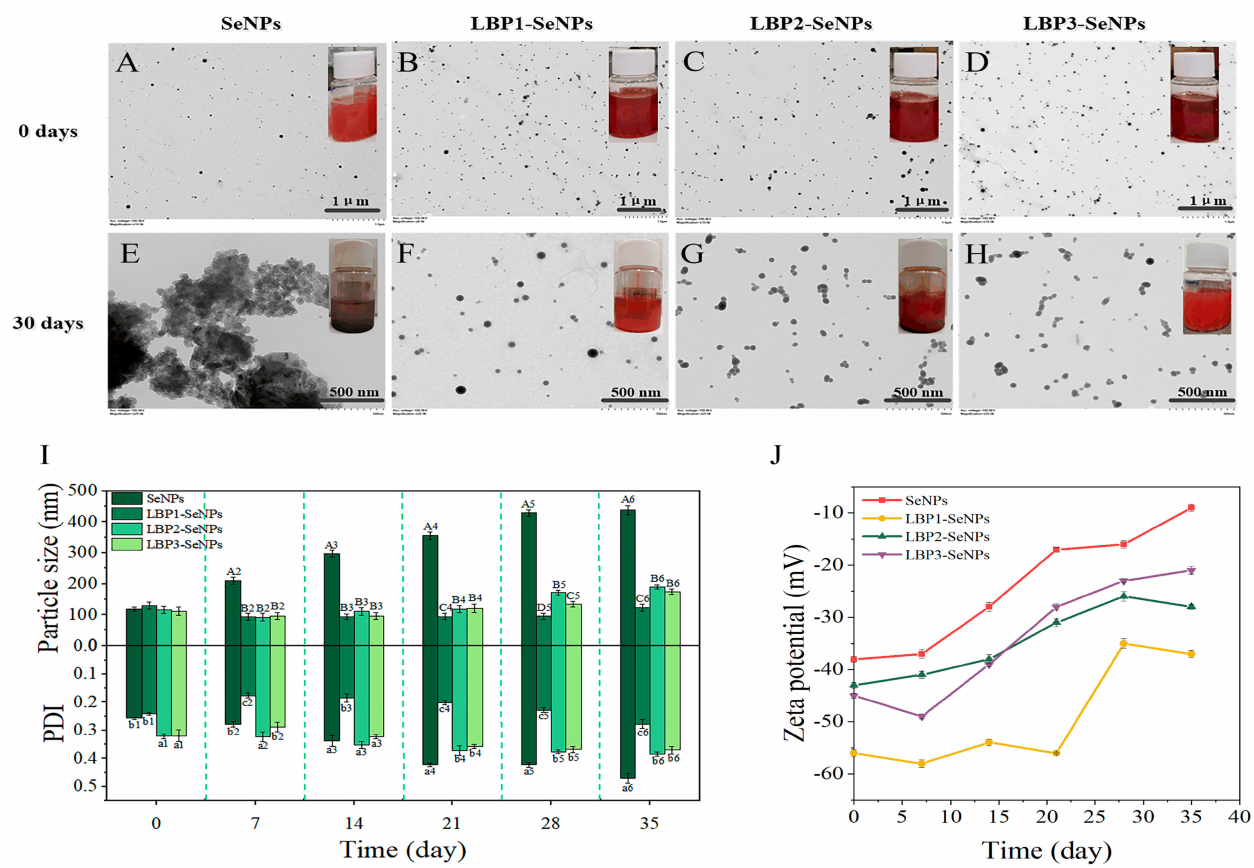
Figure 4. TEM images and optical photograph of SeNPs, LBP1-SeNPs (LBP1: 92,441 Da), LBP2-SeNPs (LBP2: 7714 Da), and LBP3-SeNPs (LBP3: 3188 Da) ( A – H ). Particle size and PDI ( I ), and zeta potential ( J ) of SeNPs and LBP-SeNPs during 35 days of storage